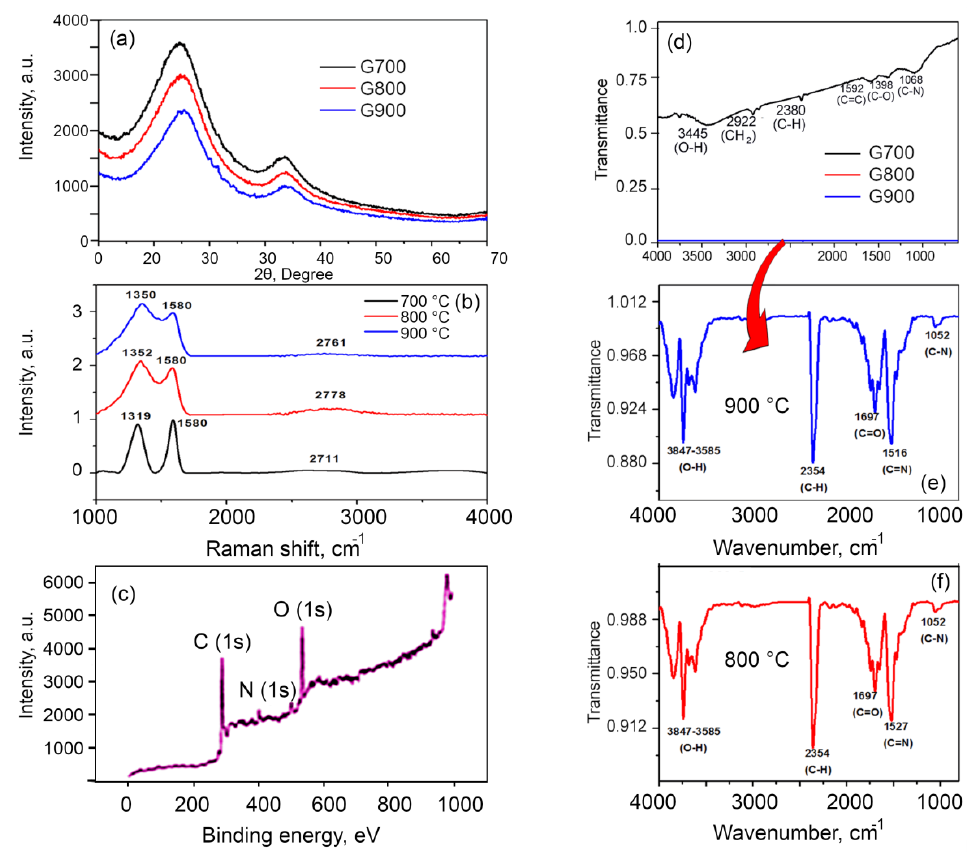
Figure 4. Characterization of the nitrogen self-doped graphene-based carbon aerogels. ( a ) XRD patterns of carbon aerogel activated at 700, 800, and 900 ◦ C. ( b ) Raman spectroscopy analysis of the 3D nitrogen self-doped graphene-based carbon aerogels activated at 700, 800, and 900 ◦ C. ( c ) XPS spectroscopy analysis of the 3D nitrogen self-doped graphene-based carbon aerogel activated at 800 ◦ C. ( d ) Fourier transform infrared (FTIR) spectra of the 3D graphene nitrogen self-doped carbon aerogels activated at 700, 800, and 900 ◦ C; ( e , f ) Enlarged FTIR spectra of the 3D graphene nitrogen self-doped carbon aerogels activated at 800 and 900 ◦